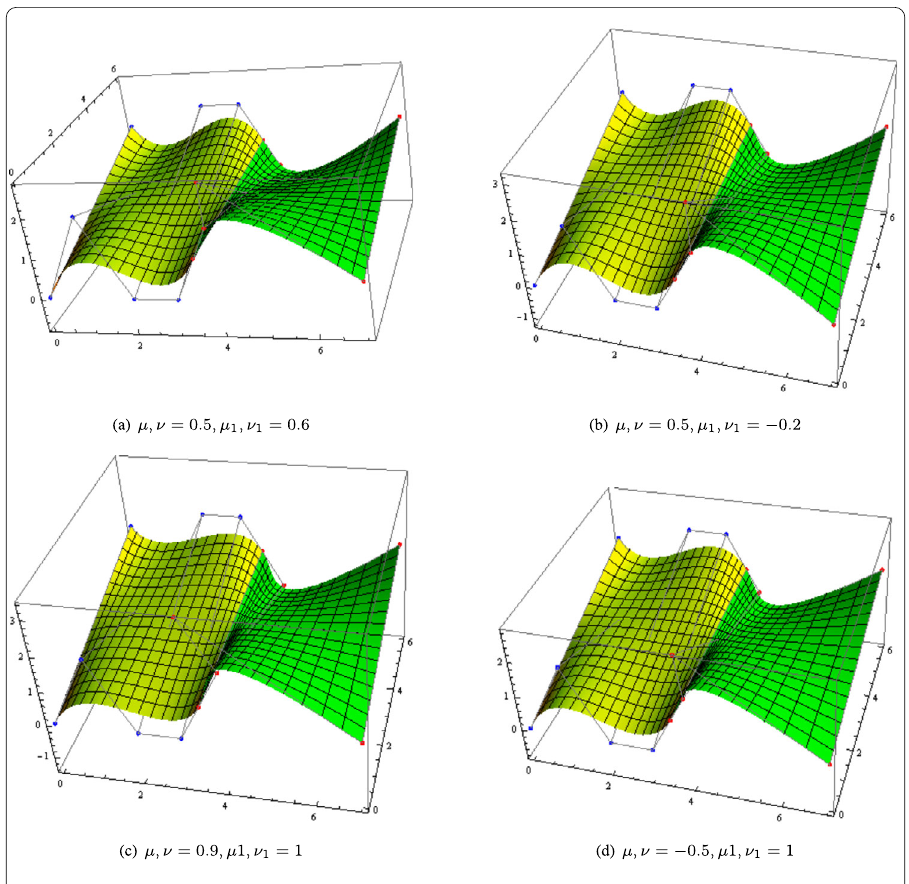
Figure 11 C 2 continuity between two GBT-Bézier ruled